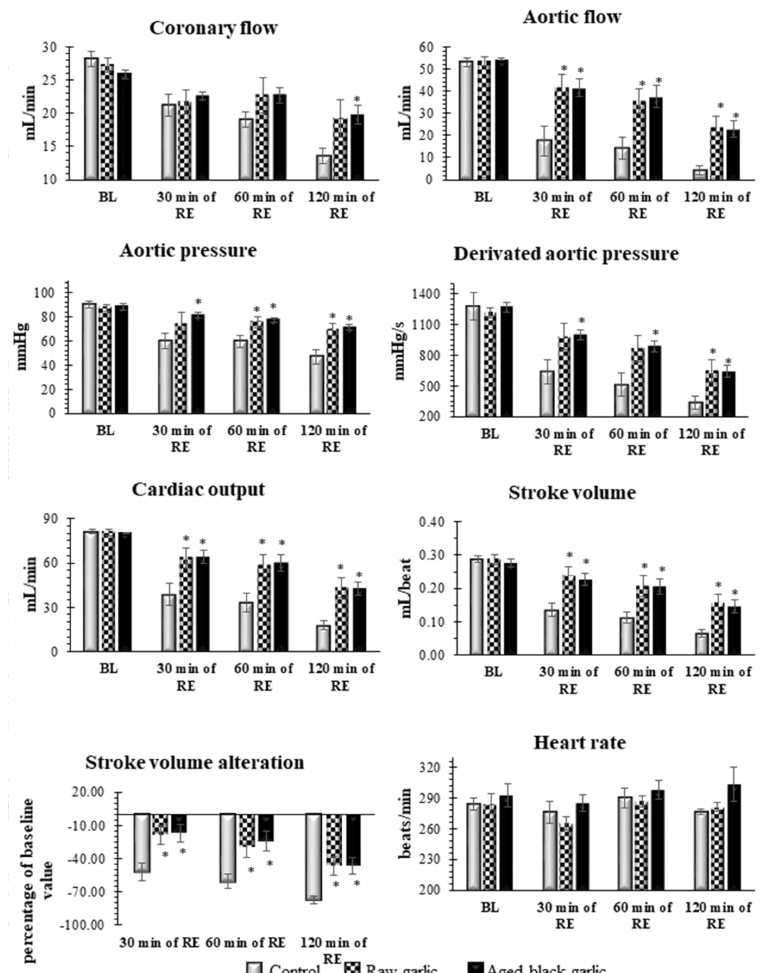
Figure 3. Effects of raw and aged black garlic on pre and postischemic cardiac functions. Following the end of the treatments, isolated hearts were subjected to 30 min of ischemia and 120 min of reperfusion. Pre- and postischemic left ventricular functions including heart rate (HR), coronary flow (CF), aortic flow (AF), aortic pressure (AOP), the first derivative of aortic pressure (AOdP/dt), stroke volume (SV), alteration in stroke volume were studied. Results are expressed as mean ± SEM n = 9 in each group. Raw garlic (RG); aged black garlic (ABG). * p < 0.05 in comparison with the control parameters within the same period. 2.4. Infarct Size Reduction by Raw and Aged Black Garlic Treatment in Ischemic Reperfused